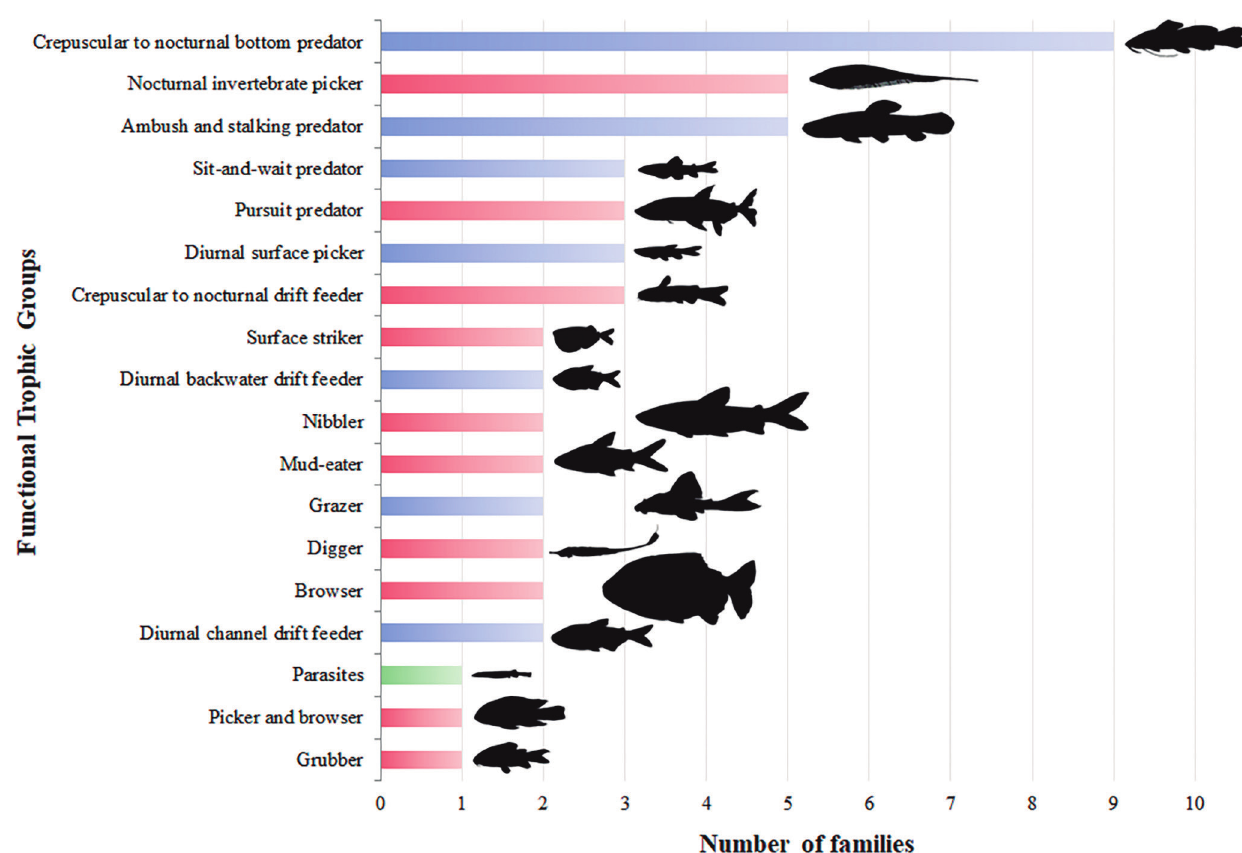
FIGURE 4 | Compilation of number of families on each Functional Trophic Group among different biomes in Brazil. Bar colors represent the shared FTGs among biomes considering Sazima (1986), Sabino, Zuanon (1998), Casatti et al . (2001), Brejão et al. (2013), Freitas et al. (2021), and this work. Blue bar: FTGs registered in Pantanal+Amazon+Atlantic Forest; Red bar: FTGs registered in Pantanal+Amazon; Green bar: FTG registered only in Amazon. Silhouettes represent the families with more records on each